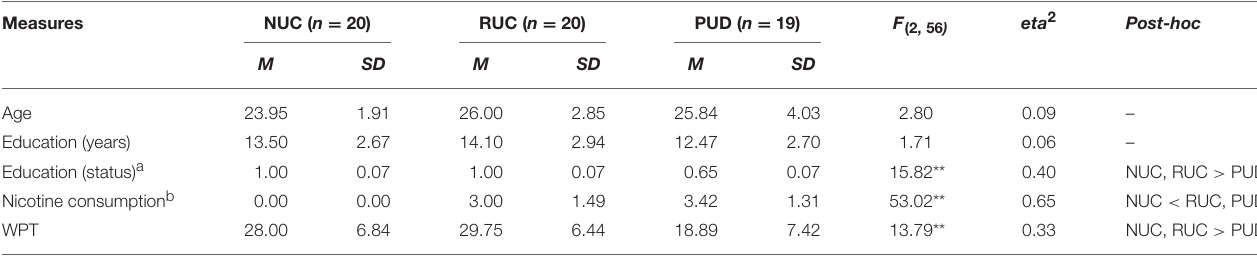
TABLE 1 | Group differences (ANOVA) in demographic data and cognitive ability.